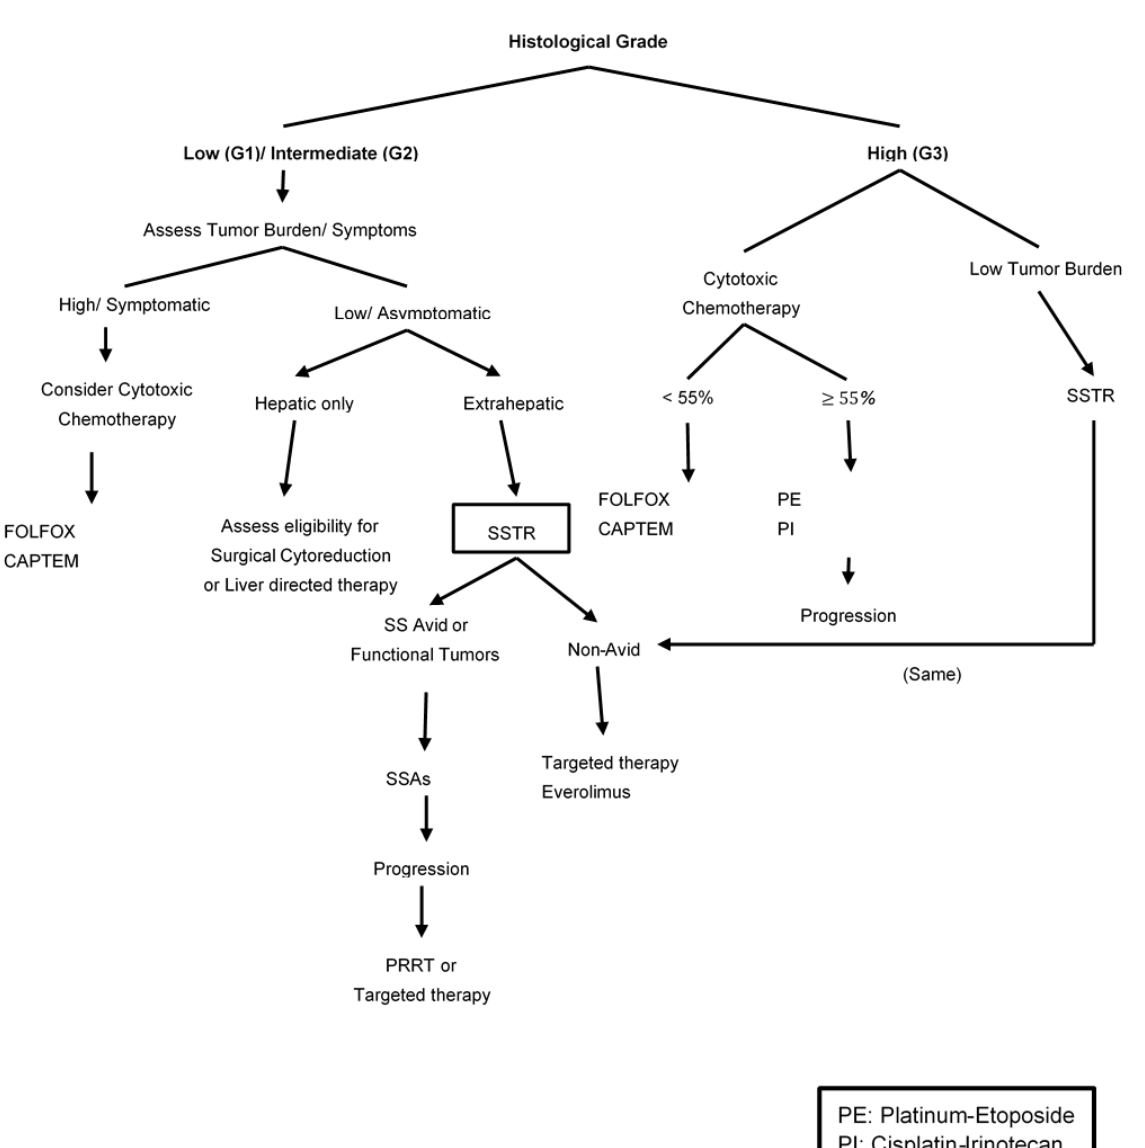
Figure 3. Therapeutic Strategy for Metastatic Well-Differentiated ANENs based on histological